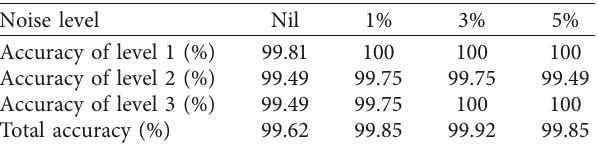
Table 6: The accuracy of depth level classification results at dif- ferent measurement noises.